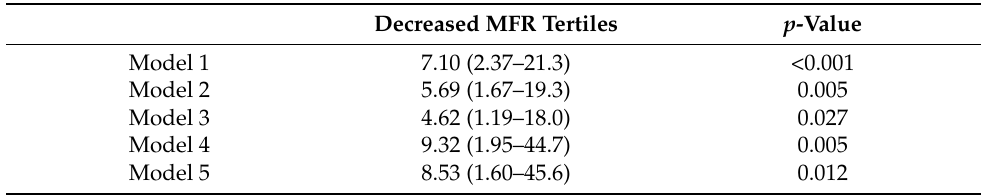
Table 2. Adjusted odds ratio (95% confidence interval) of decreased muscle-to-fat mass ratio ter- tiles for serum alanine aminotransferase >26 U/L (screening indicator for NAFLD).